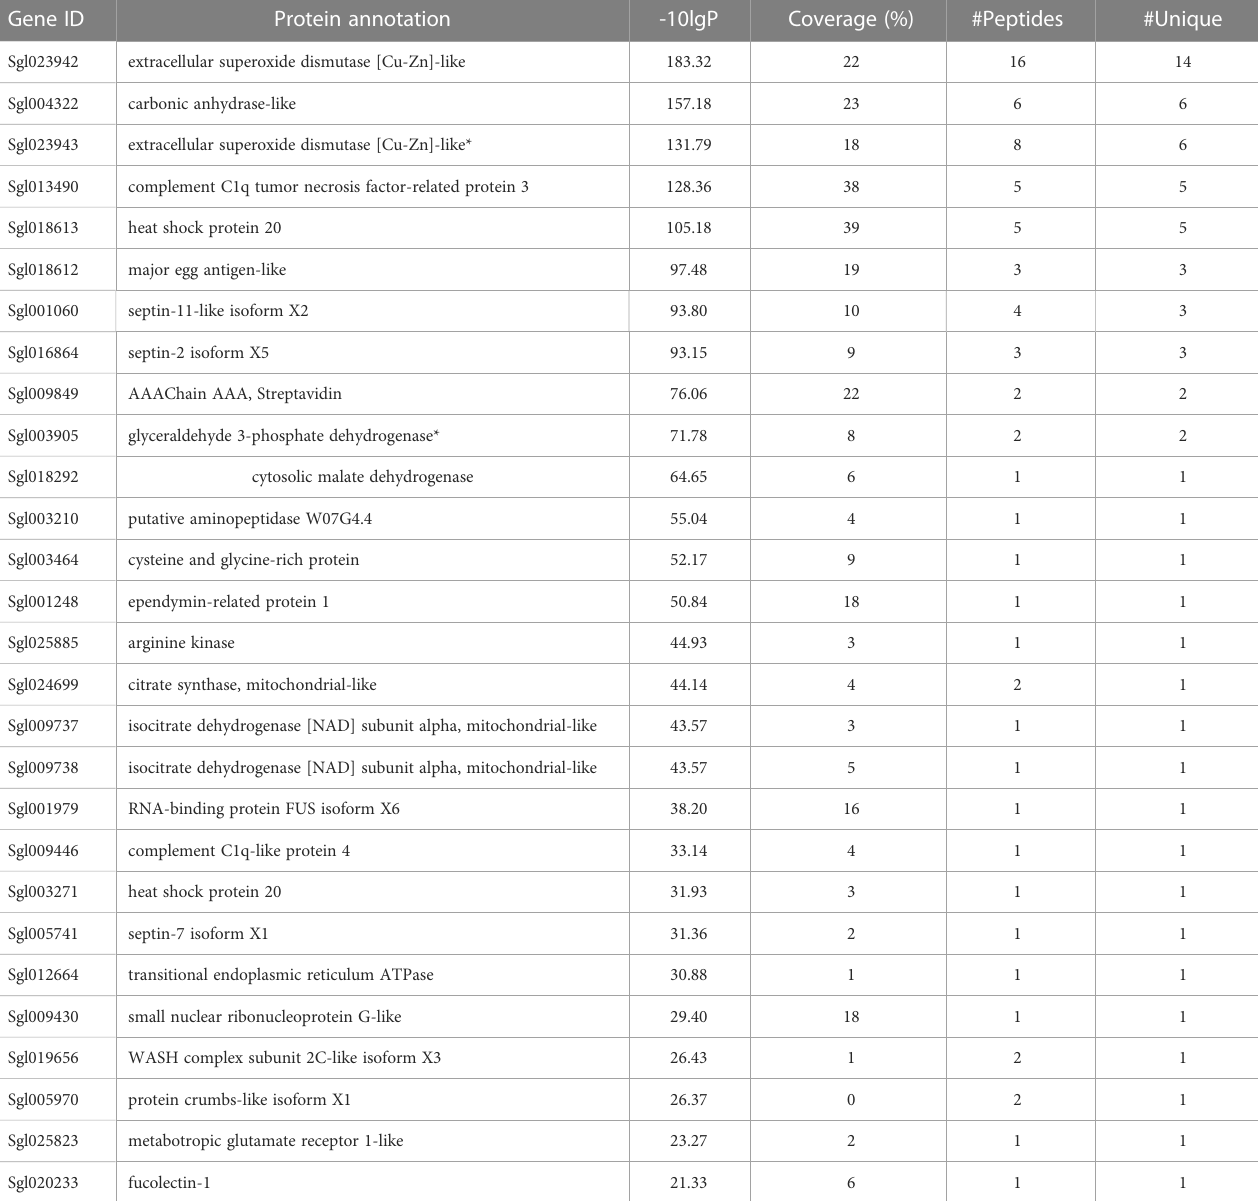
Gene ID Protein